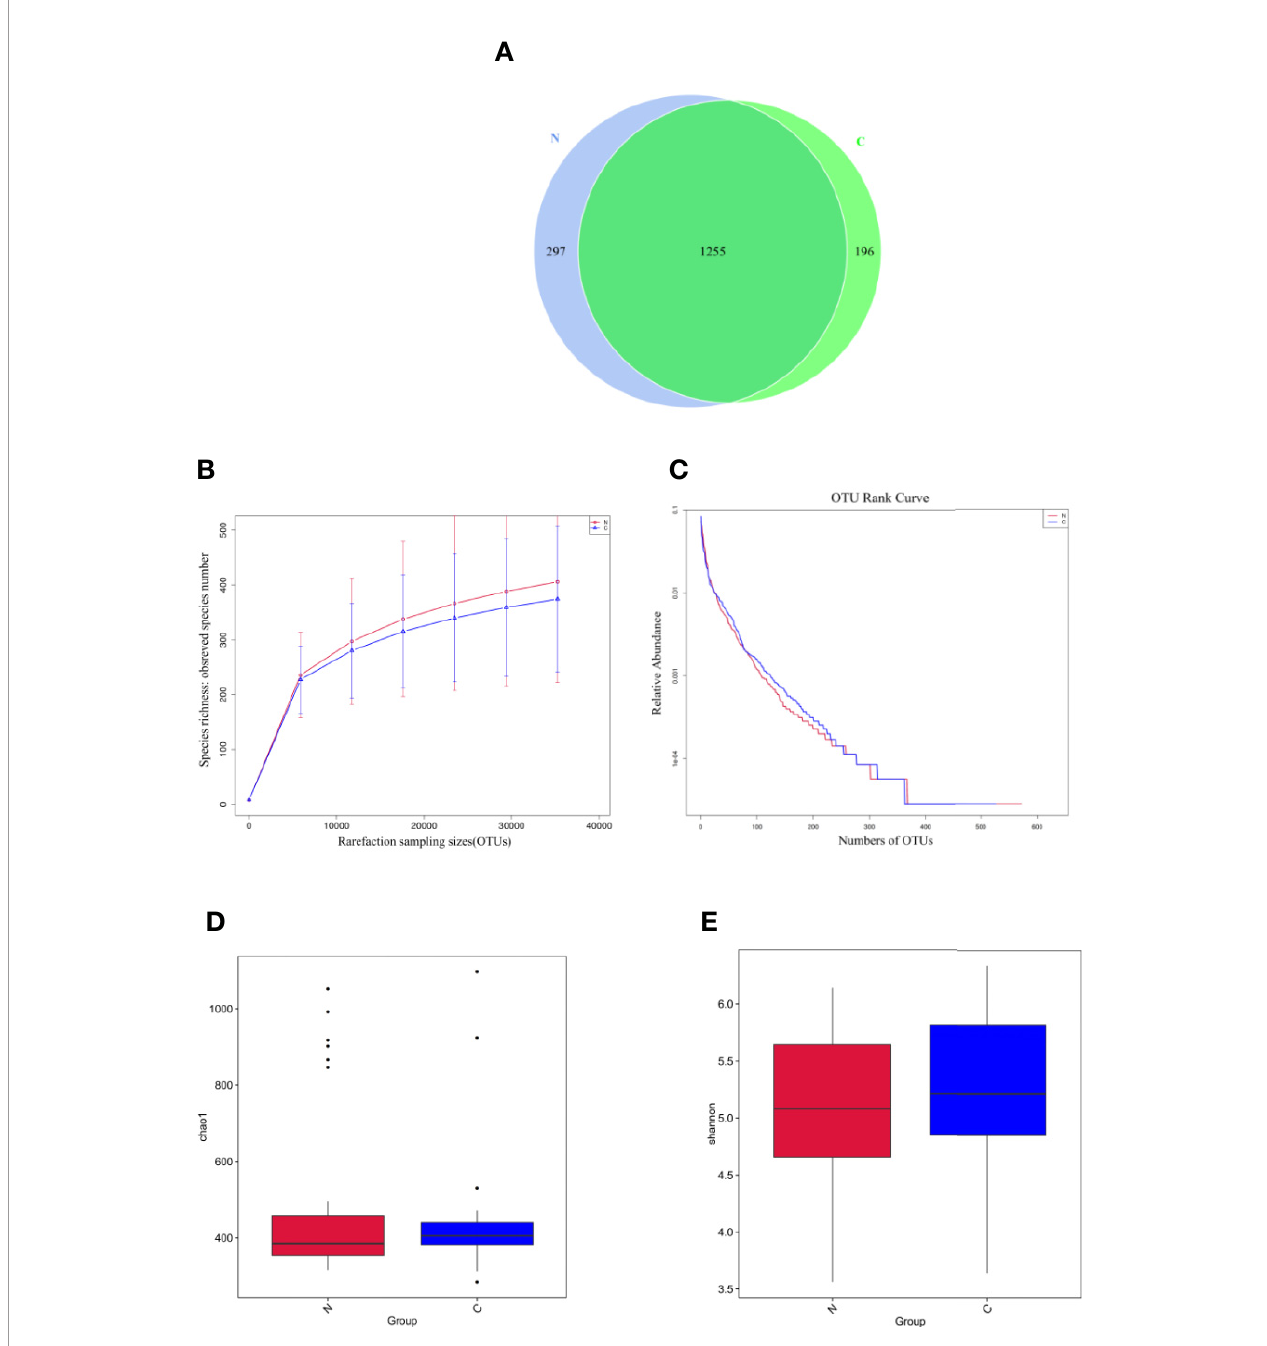
FIGURE 1 | Species richness and diversity of the gut microbiome in two groups. N refers to the normal group; C refers to the constipated group. (A) Species richness and evenness based on the Venn diagram. The species richness in the constipated group is lower than that in the healthy group. (B) The rarefaction curve can directly re fl ect the rationality of sequencing data and indirectly re fl ect the richness of species in two groups. (C) The rank abundance curve re fl ects the richness and evenness of the species in two groups. (D) The Chao1 plot re fl ects species richness. (E) The Shannon plot re fl ects species